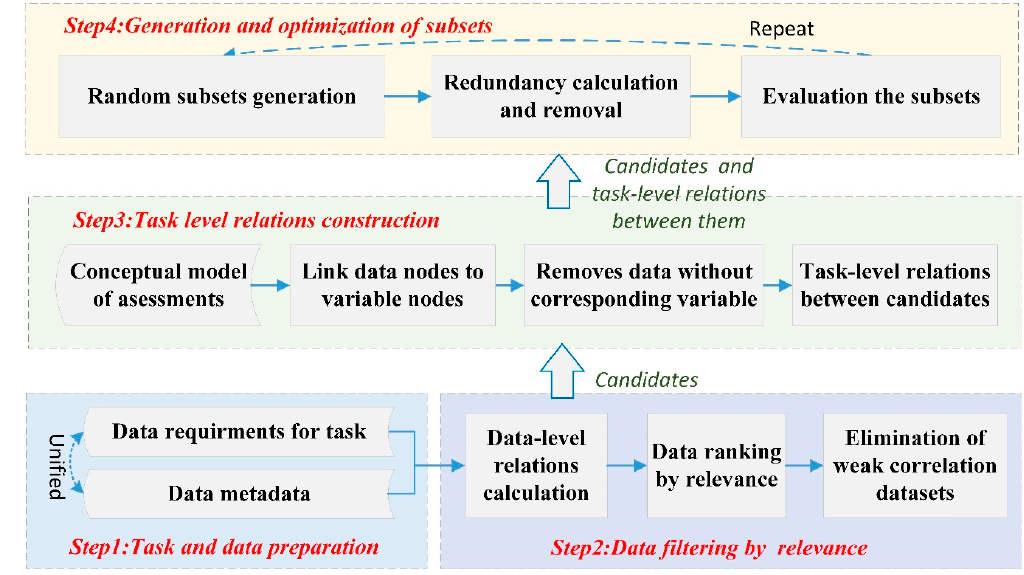
Figure 5. Flowchart of advantage information selection from the original datasets.